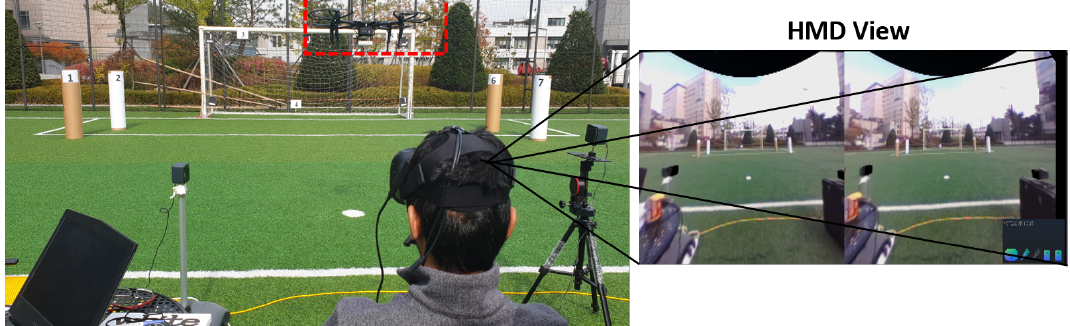
Figure 7. Experimental setup and participant performing the experiment.